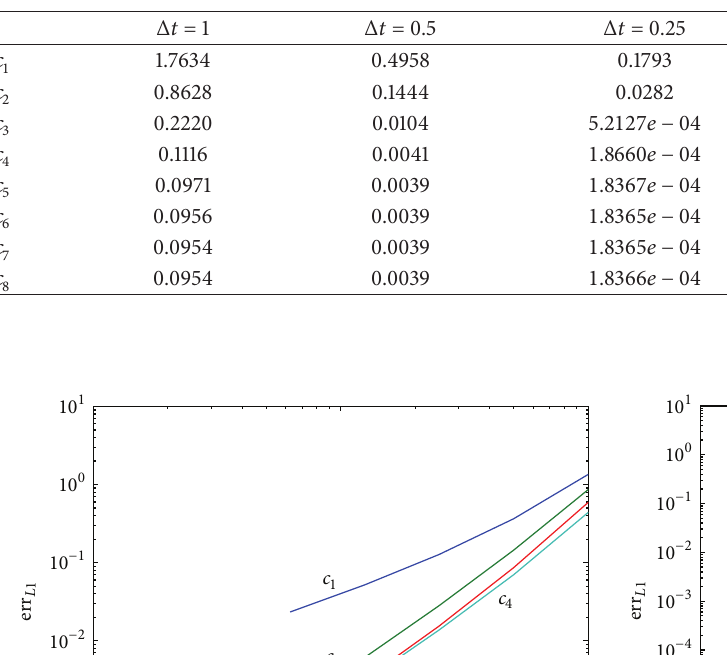
Table 1: Numerical experiment with 10 iterative steps for the first example.